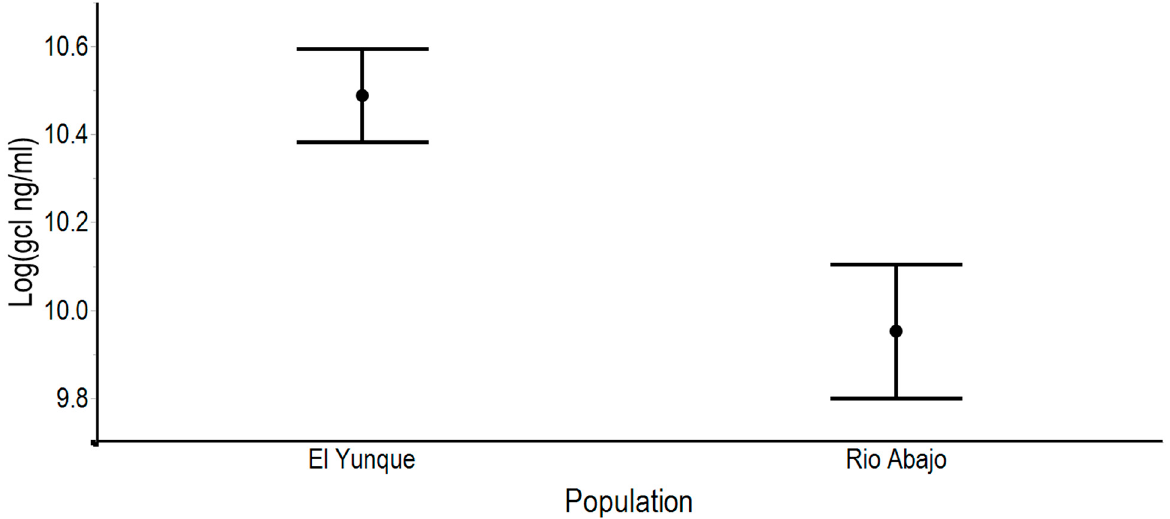
Figure 5. Populations comparison in fecal glucocorticoid metabolites between males in the Rio Abajo (12) and El Yunque (9) captive populations during the 2017 breeding season. Graphs show means ± SE.